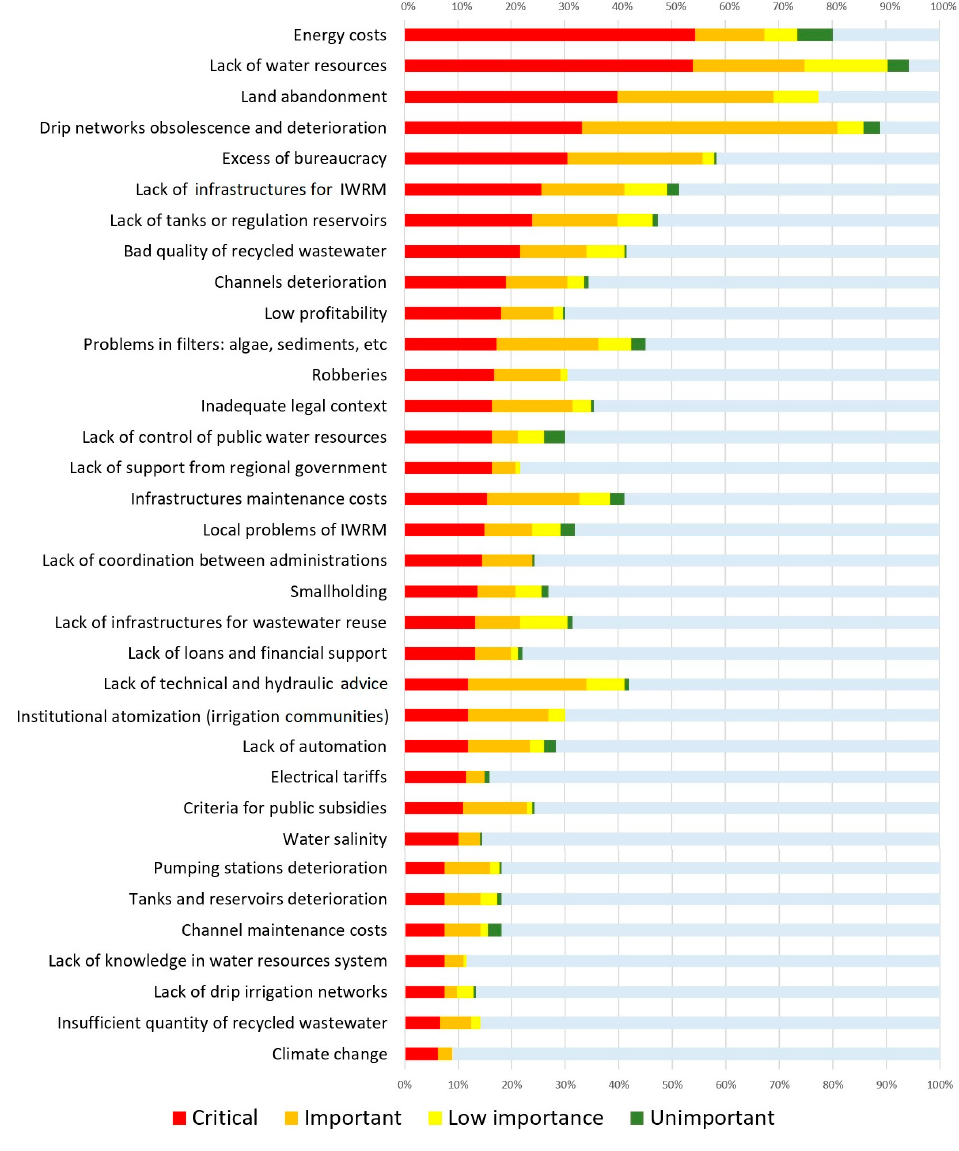
Figure 2. Assessment of the irrigation sector problems: results of the attendee assessment in terms of percentage of total votes.